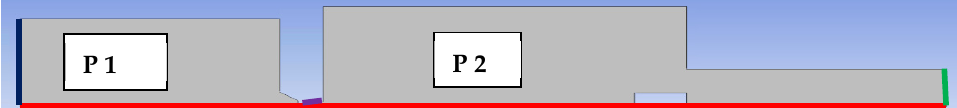
Figure 10. Boundary conditions on the 2D model of the experimental chamber. The outlet of chamber P2 (green area in Figure 10) has been set to the pumping rate of the planned Lavat pump which was converted to a flow rate of 2 m/s for a given cross-section. The calculation was solved as axisymmetric, where the axis of symmetry is marked in red in Figure 10.